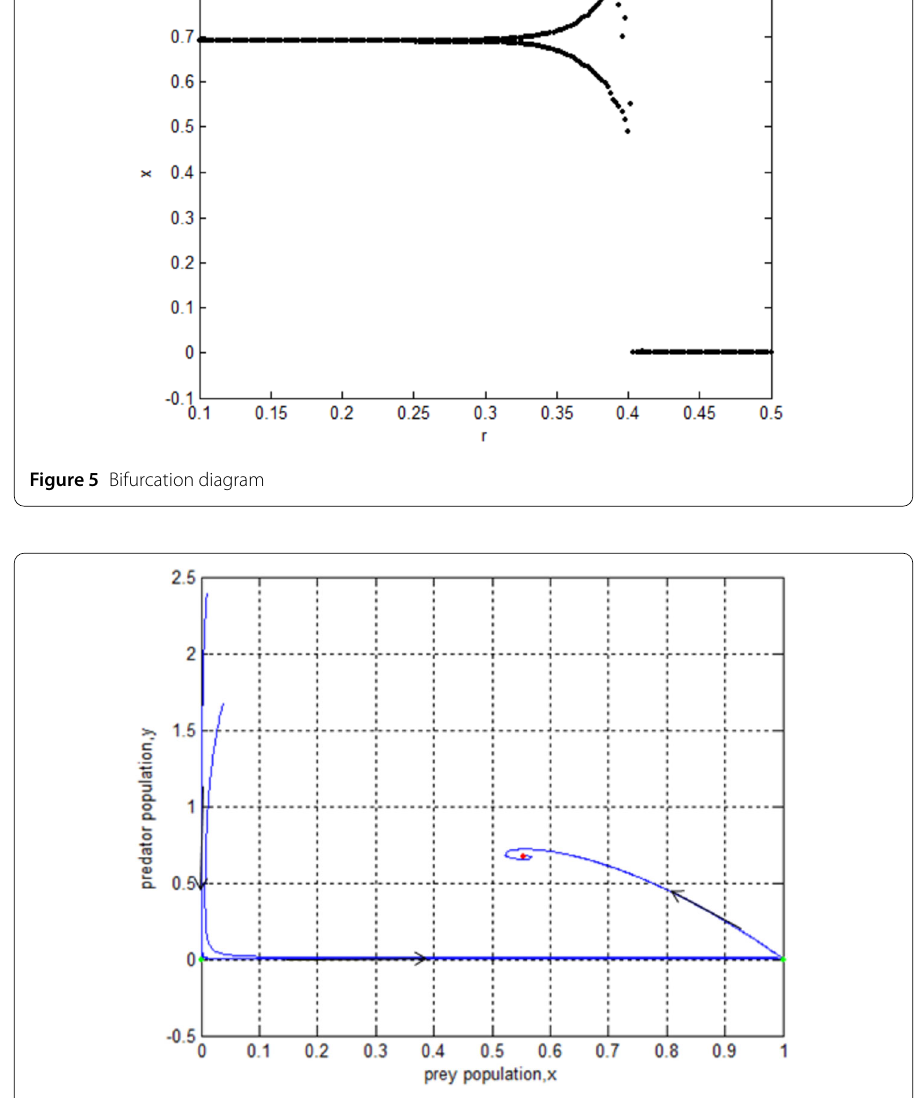
Figure 6 E w 0 = (0,0) is a saddle point, E w 2 = (1,0) is a saddle point and E w ∗ = ( ¯ x ∗ , ¯ y ∗ ) = (0.556,0.671) is